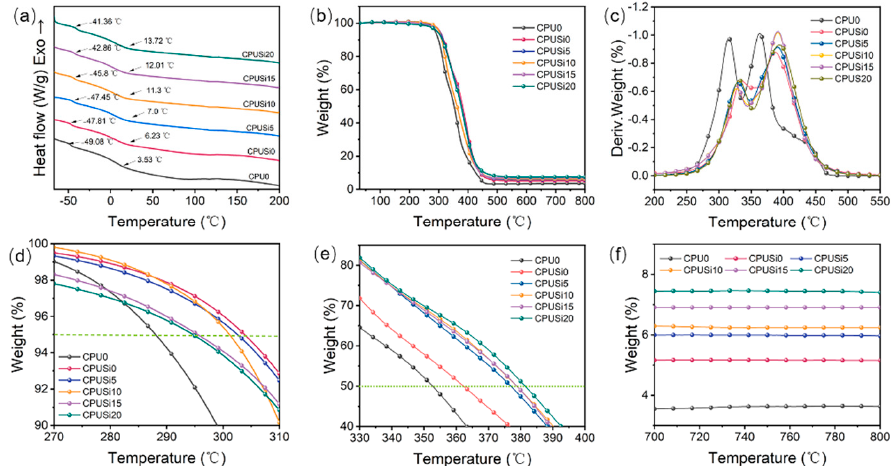
Figure 4. ( a ) DSC curve of CPU and CPUSi hybrids films; ( b ) TGA curve of CPU and CPUSi hybrids films; ( c ) DTG curve of CPU and CPUSi hybrids films; ( d ) TGA curve at 270–310 °C; ( e ) TGA curve at 330–400 °C; ( f ) Char residue at 800 °C.